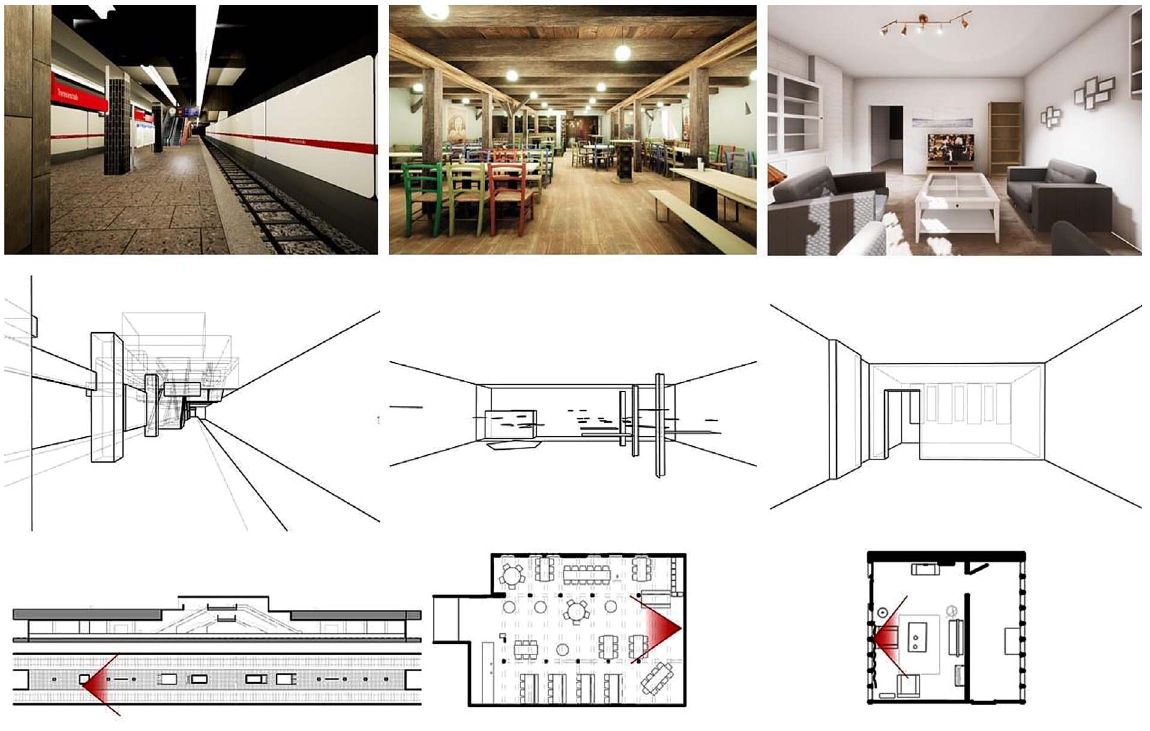
Figure 1. The three example environments underground station, pub, and living room (left to right) modelled after an underground station in the center of Munich, the OLs Brauhaus in Oldenburg, and the Living room Laboratory created at the University of Oldenburg for research purposes. Upper row: Visual rendering in Unreal engine. Middle row: Wire frame representation of the simpli fi ed geometry for room acoustics simulation. Lower row, the view frustum of the renderings is indicated in the fl oor plans which are depicted in more detail in Figures 2 –